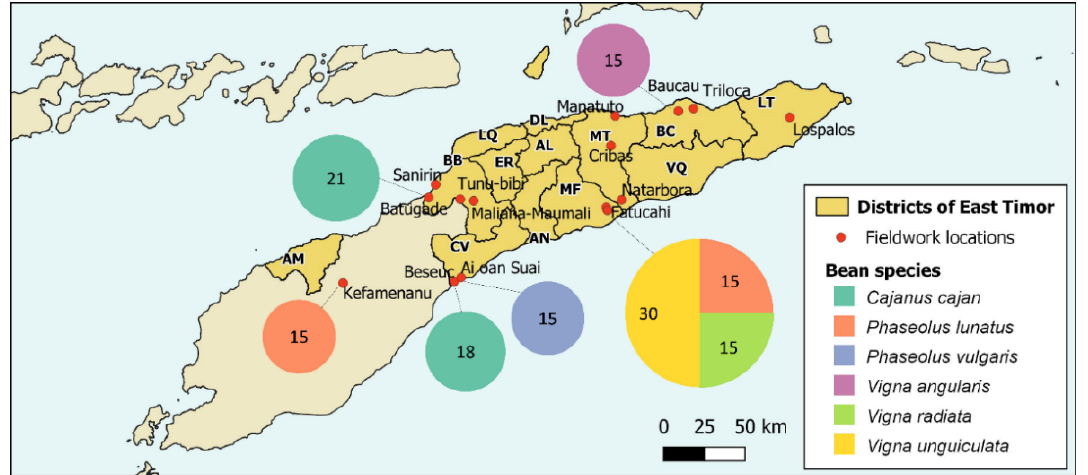
Figure 1. Map of Timor with the districts of East Timor (AL — Aileu; AN — Ainaro; BC — Baucau; BB — Bobonaro; CV — Cova-Lima; DL — Díli; ER — Ermera; LT — Lautém; LQ — Liquiçá; MT — Manatuto; MF — Manufahi; AM — Oecussi-Ambeno; VQ — Viqueque) and the locations of fieldwork. The size of the circles represents the number of samples of beans collected in each location.